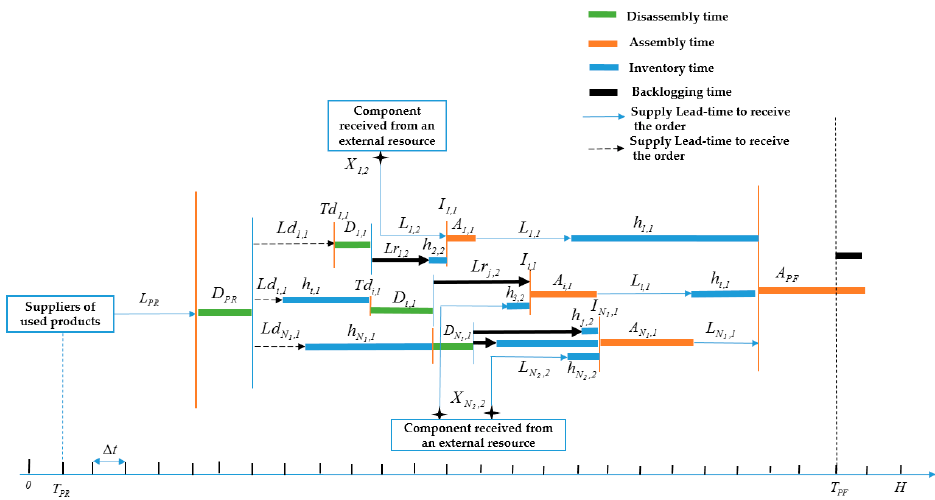
Figure 3. Description of one manufacturing finished product